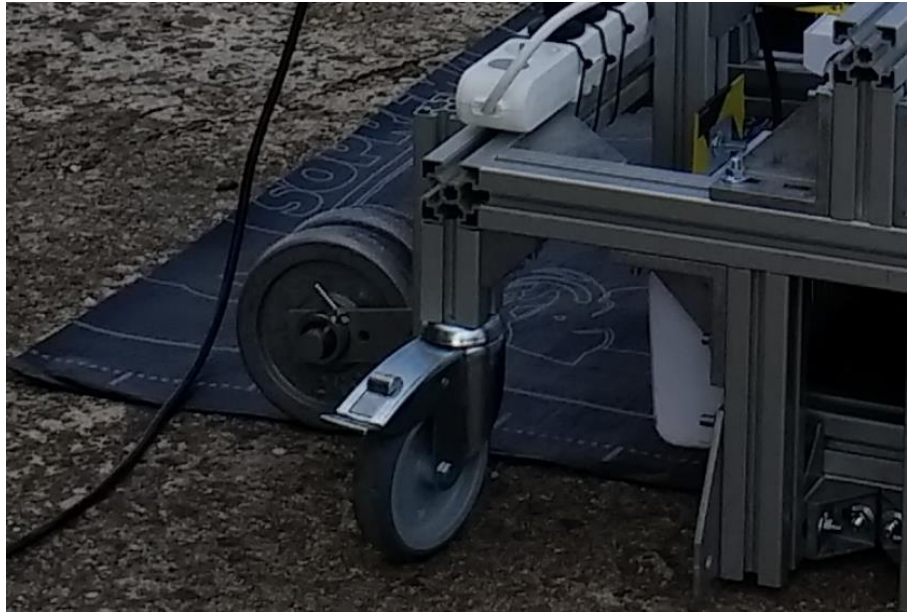
Figure 11. Detail of the small drum roller for the sealing of overlaps.